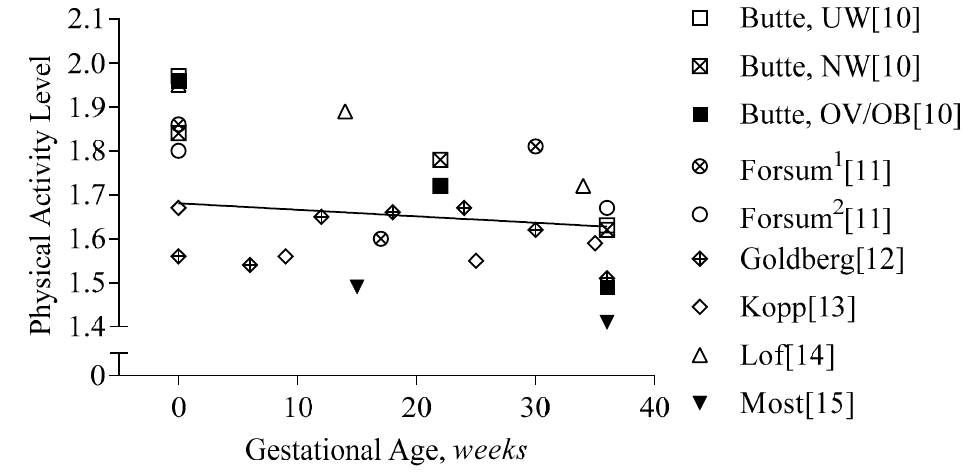
Figure 4. Physical activity level during gestation. Physical activity level is presented per study and gestational age (GA). The regression line represents the average decline in the physical activity level during gestation (PAL = 1.68 − 0.0015 × GA[ weeks ], R 2 = 0.02). Forsum 1 and Forsum 2 indicate the two different cohorts in the study: both measured before pregnancy, but at different times during gestation; Butte reported the changes in PAL per BMI class: ‘UW’ indicates underweight: BMI ≤ 19.8 kg/m 2 , ‘NW’ indicates normal weight: BMI 19.8–26 kg/m 2 , and ‘OV/OB’ indicates overweight/obesity: BMI ≥ 26 kg/m 2 .